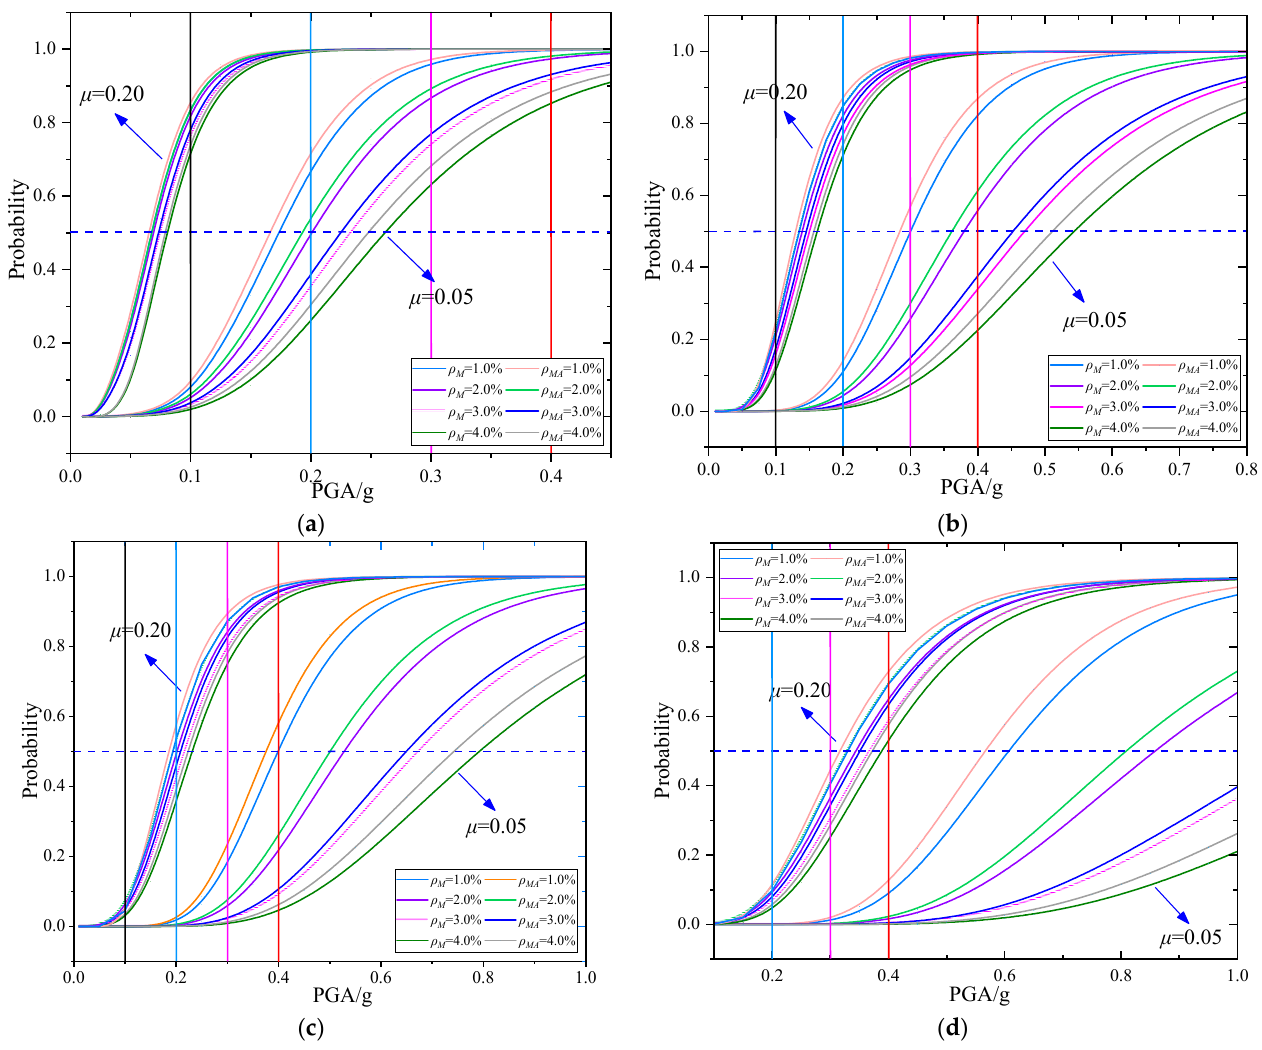
Figure 10. Fragility curves of the column under MS-AS: ( a ) minor damage; ( b ) medium damage; ( c ) severe damage; ( d ) complete failure.